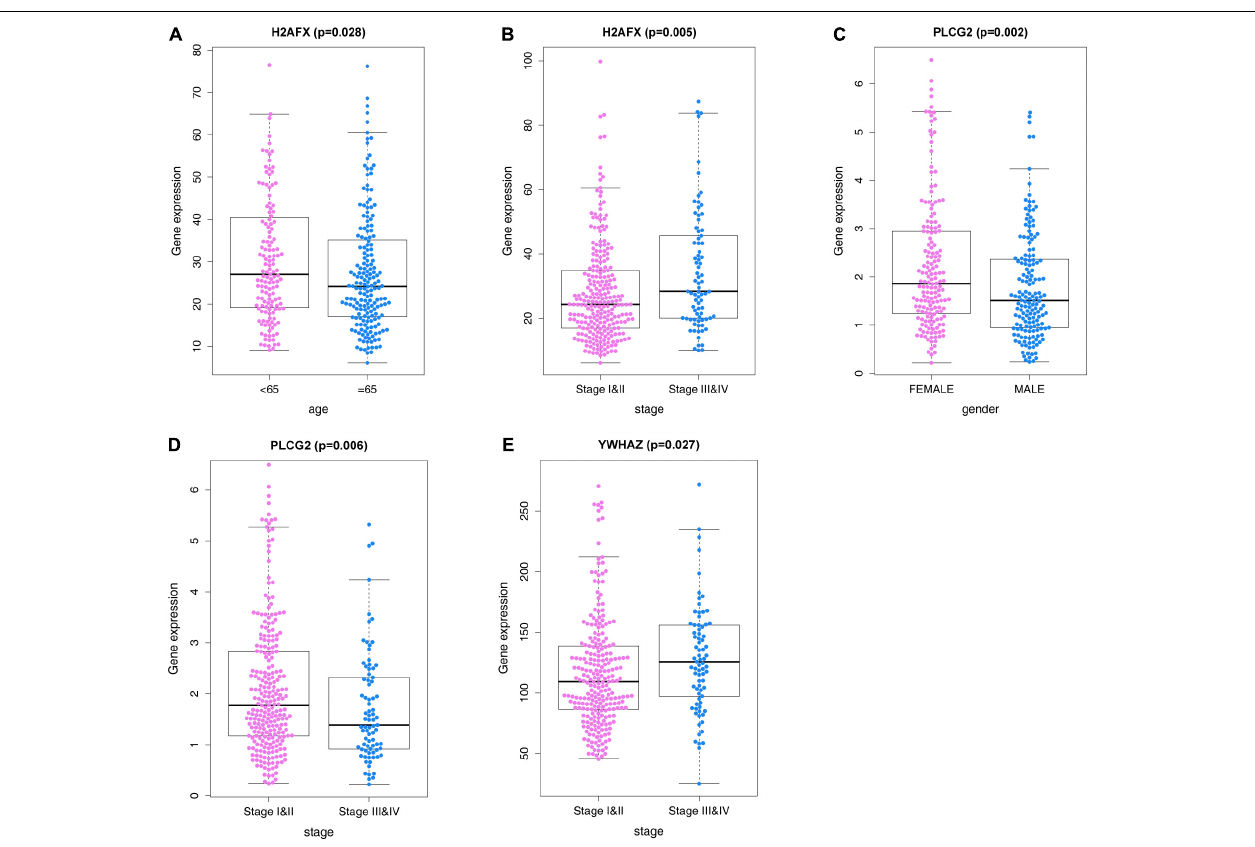
FIGURE 7 | ARGs and correlations with clinicopathological characteristics. (A) H2AFX and age. (B) H2AFX and stage. (C) PLCG2 and sex. (D) PLCG2, and stage. (E) YWHAZ and stage.